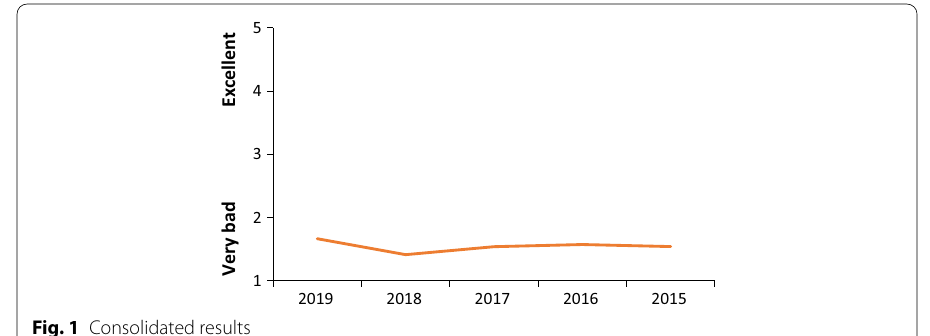
Fig. 1 Consolidated